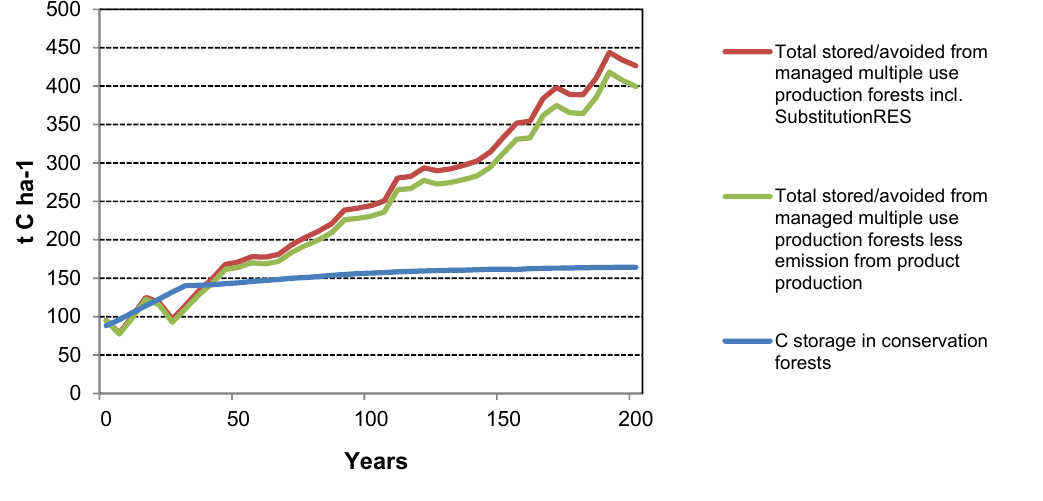
Figure 9. GHG implications of the “ production ” and “ conservation ” scenarios for NC forests (t C ha − 1 sequestered or displaced); total mitigation benefit includes Substitution and the net mitigation benefit discounting life cycle emissions over a 200 year period.